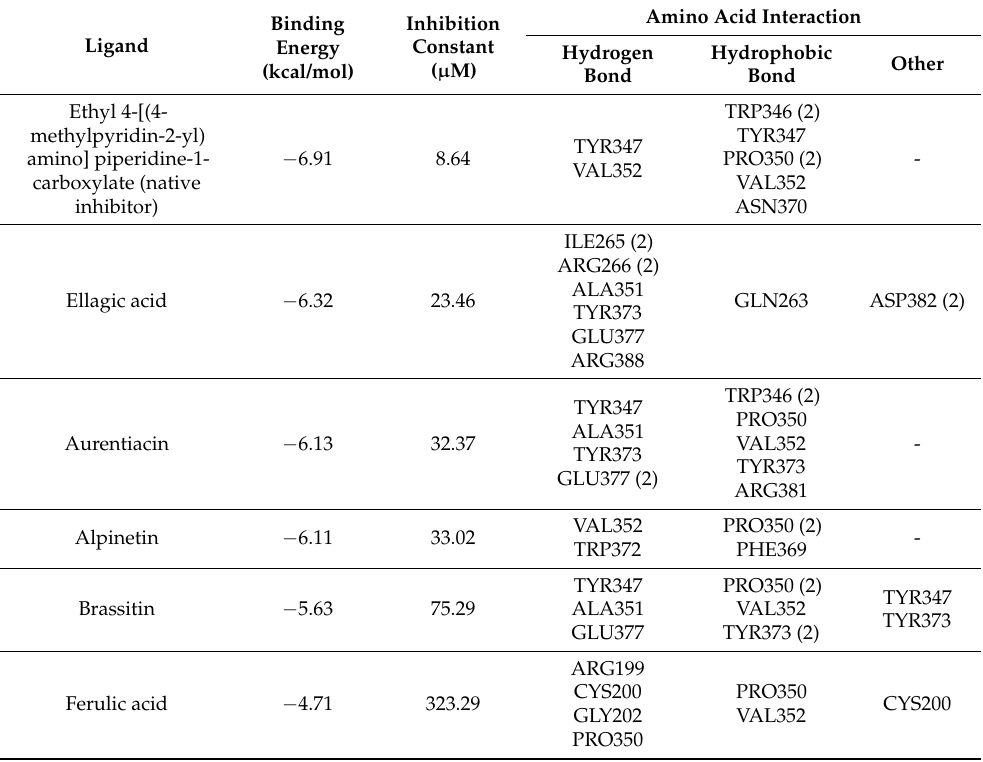
Table 3. Molecular docking results of top 5 identified compounds to iNOS binding site. Ligand